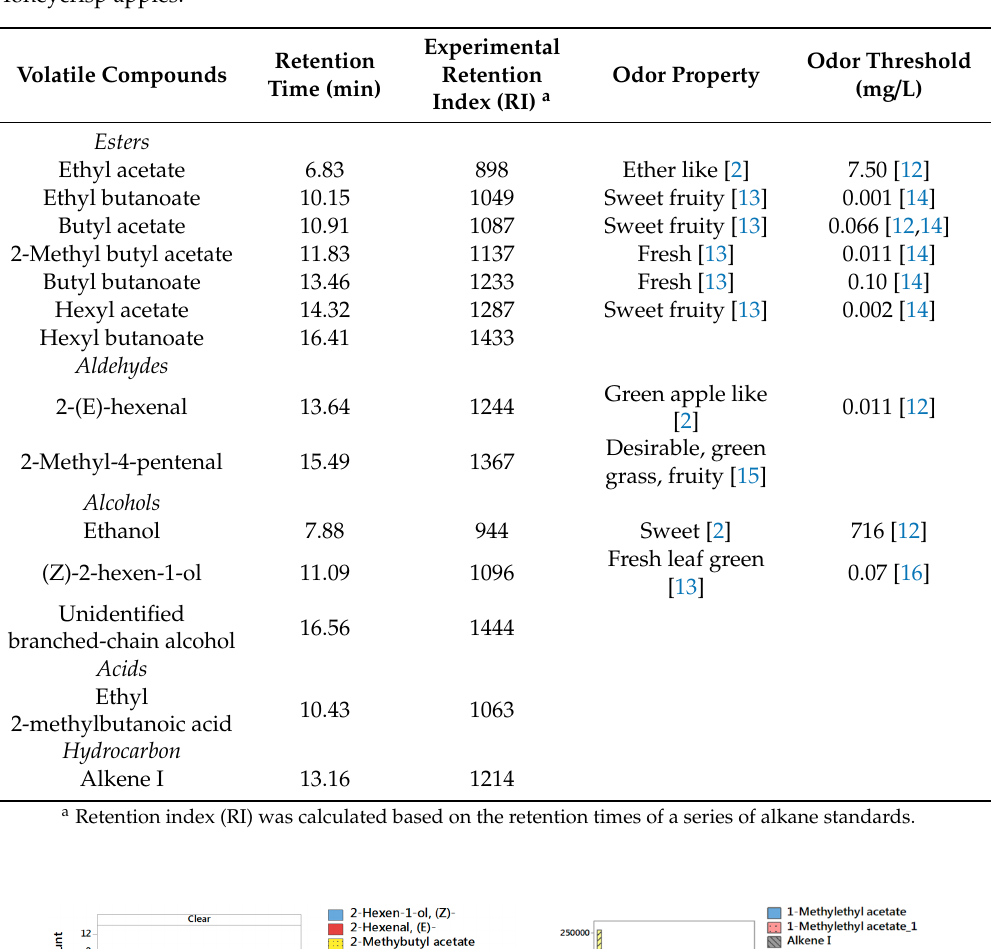
Table 1. Major volatile compounds isolated from clear and cloudy apple juice of McIntosh and Honeycrisp apples.